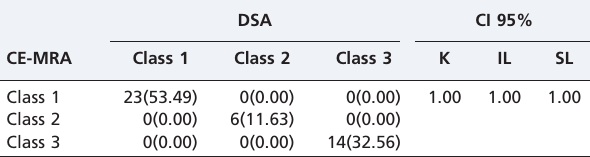
Table 2 - Aneurysm occlusion status as assessed by DSA and CE-MRA, with Raymond’s classification, after interobserver consensus.